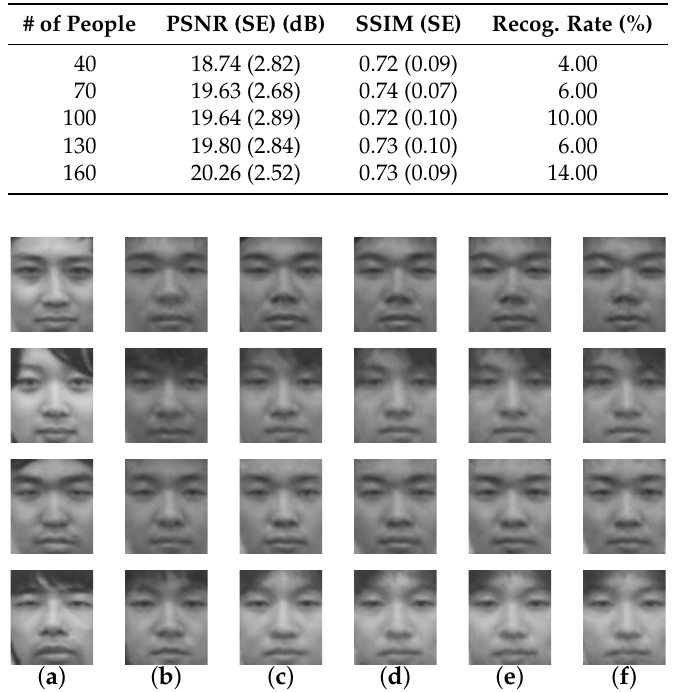
Table 4. Type B: Evaluation of different numbers of training data (Number of neighbors: 5, patch size: 9 × 9 pixels). SE represents the standard error.